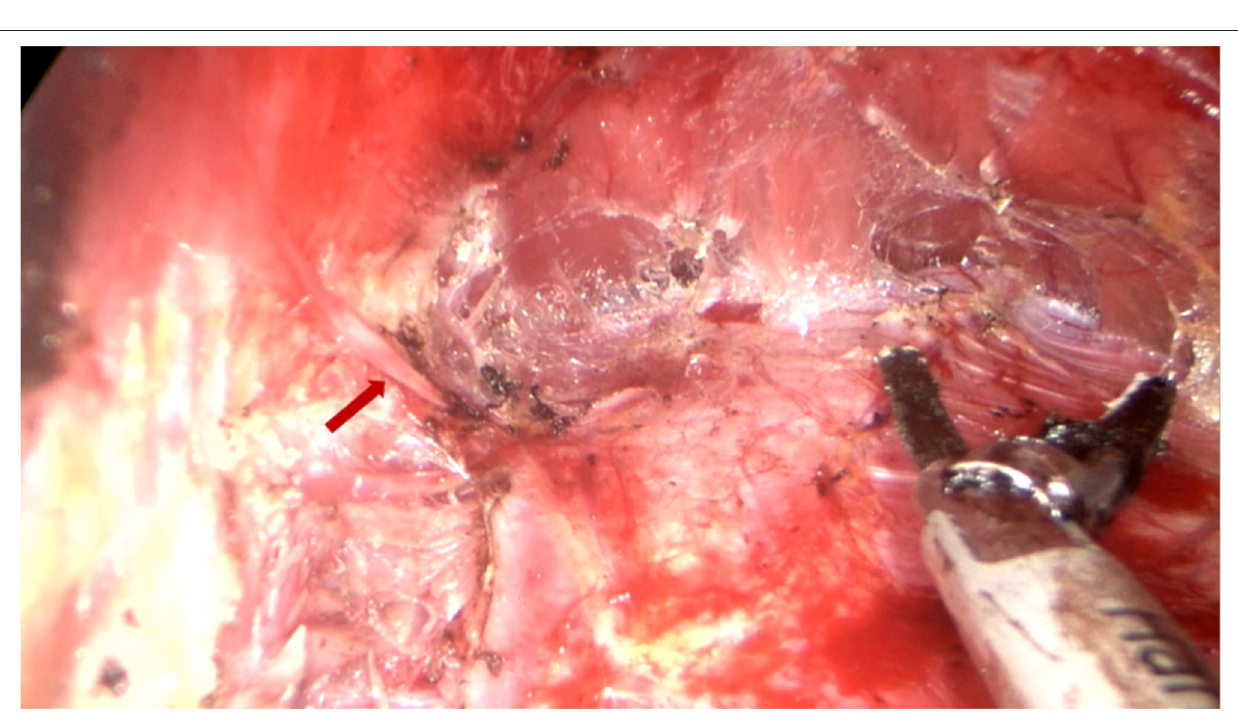
180–300 cc were used. The average operation time was 155.92 ± 22.34 min, and the average cost of surgery was 16,740.79 ± 373.96 RMB. And the cost of endoscopy and ultrasonic knife accounts for about 14% of the total cost. Detailed